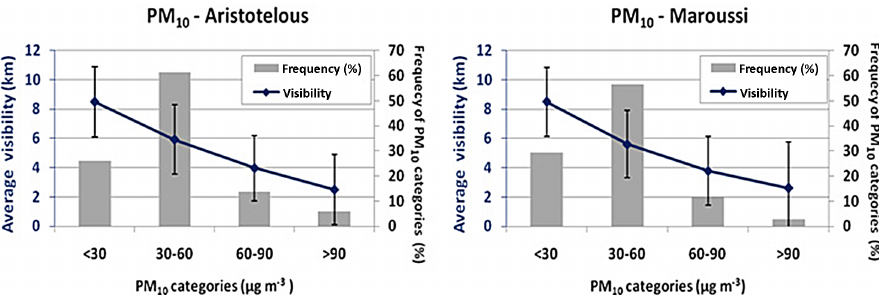
Figure 14. Visibility as a function of different classes of PM 10 levels at an urban (Aristotelous, left graph) and a suburban (Maroussi, right graph) station in Athens. Measurements refer to the period 2008–2012. Geometric average and standard deviation are applied on visibility observations. Relative frequencies of different PM 10 classes are also shown (grey bars).